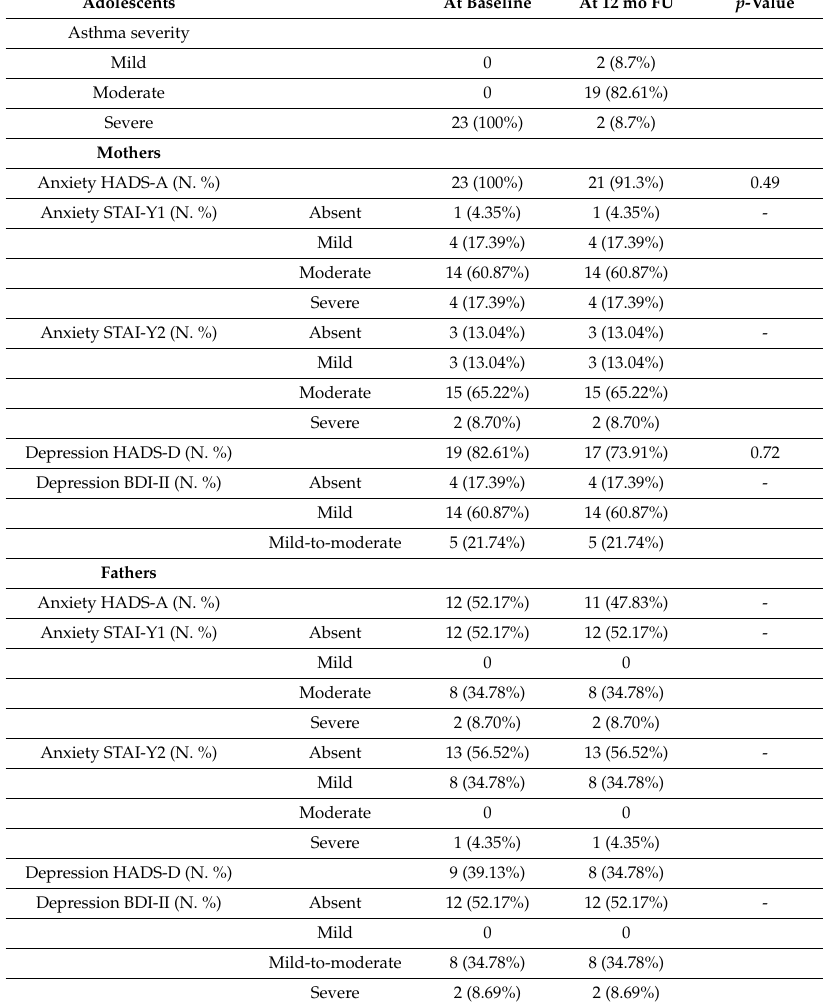
Table 2. Emotional data of the parents of anxious adolescents with severe asthma at baseline and at 12 month follow-up